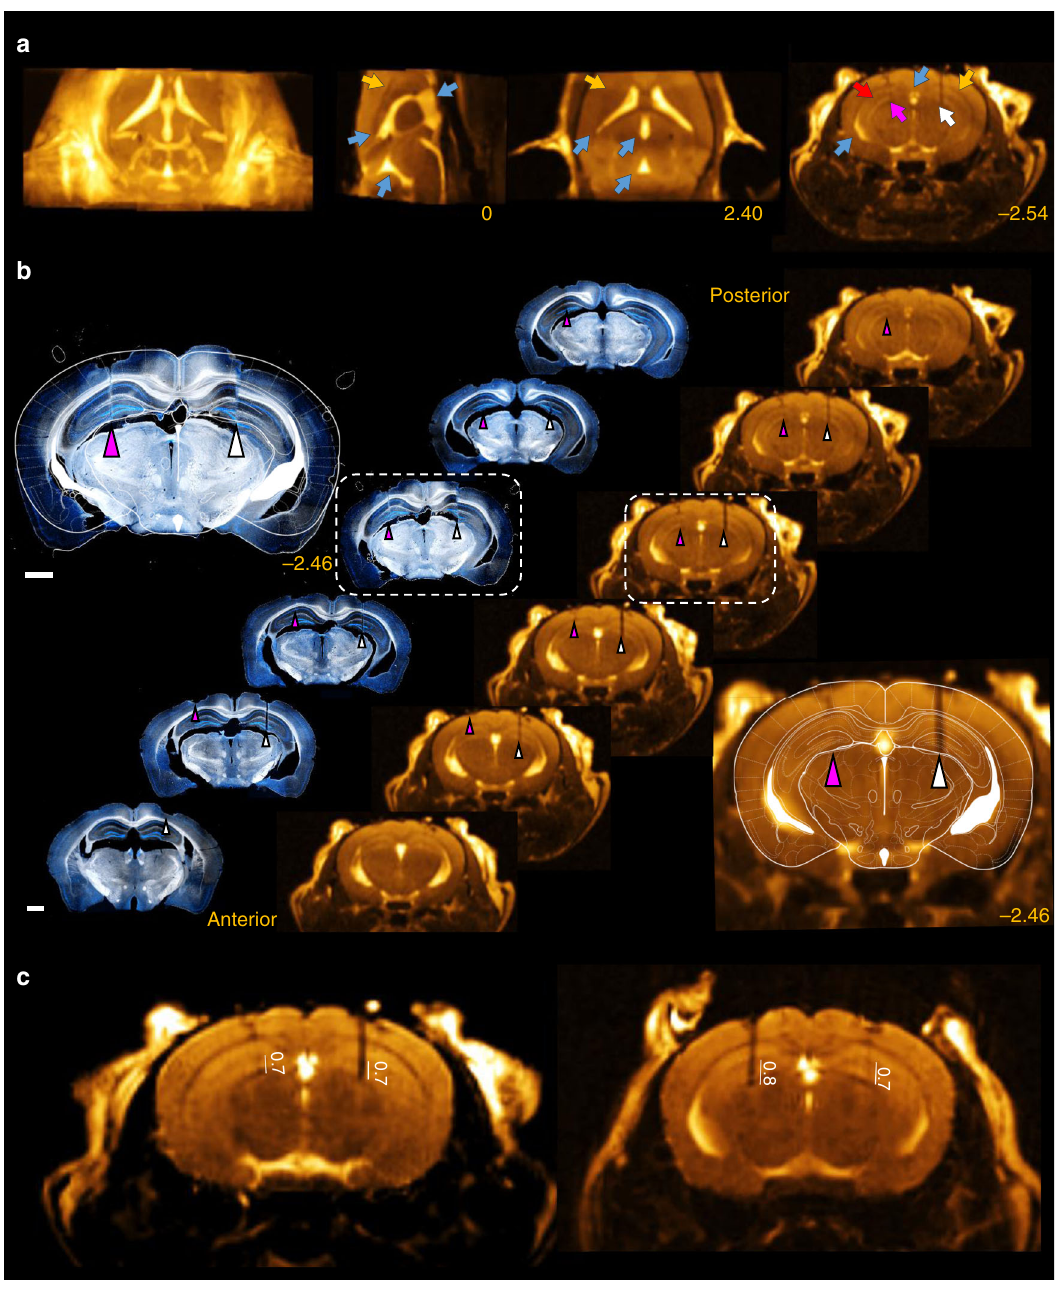
Fig. 6 Localization of nonmetal implants with postoperative MRI imaging. a The postoperative T 2 /T 1 -weighted MRI image shows the tracks of bilaterally implanted optic fi bers (magenta arrow, 50- µ m core diameter, right hemisphere; white arrow, 105- µ m core diameter, left hemisphere). Anatomical landmarks are discernable, including ventricles (blue arrows), the corpus callosum (yellow arrows), and the hippocampal fi ssure (red arrow). Images from left to right, maximum intensity projection, sagittal slice, horizontal slice, and coronal slice. Yellow numbers refer to the corresponding stereotaxic coordinates in mm relative to Bregma. b Slice-by-slice comparison of the in vivo postoperative MRI images (right) and histology (left, dark- fi eld images overlaid with fl uorescent micrographs of nuclear DAPI staining). The corresponding coronal plane of the Paxinos atlas was fi tted on the slices marked by white dashed boxes. Scale bar, 1 mm. c High signal-to-noise ratio (SNR) postoperative T 2 -weighted MRI images were acquired from thick (600- µ m) coronal slices from both animals. Numbers indicate the depth of the implant tips relative to the hippocampal fi ssure in mm. MRI images are shown in